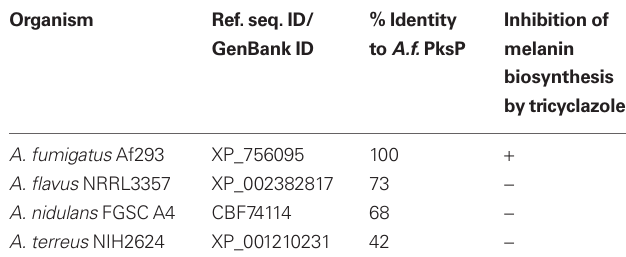
Table 2 | BlastP analysis and inhibition of conidial melanin by